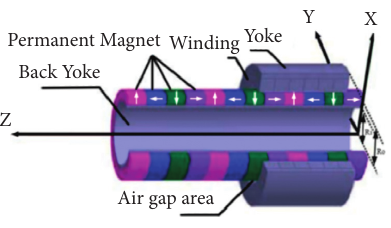
Figure 1: The ITPMSLM topology. Figure 2: The RPMS of the Halbach array.